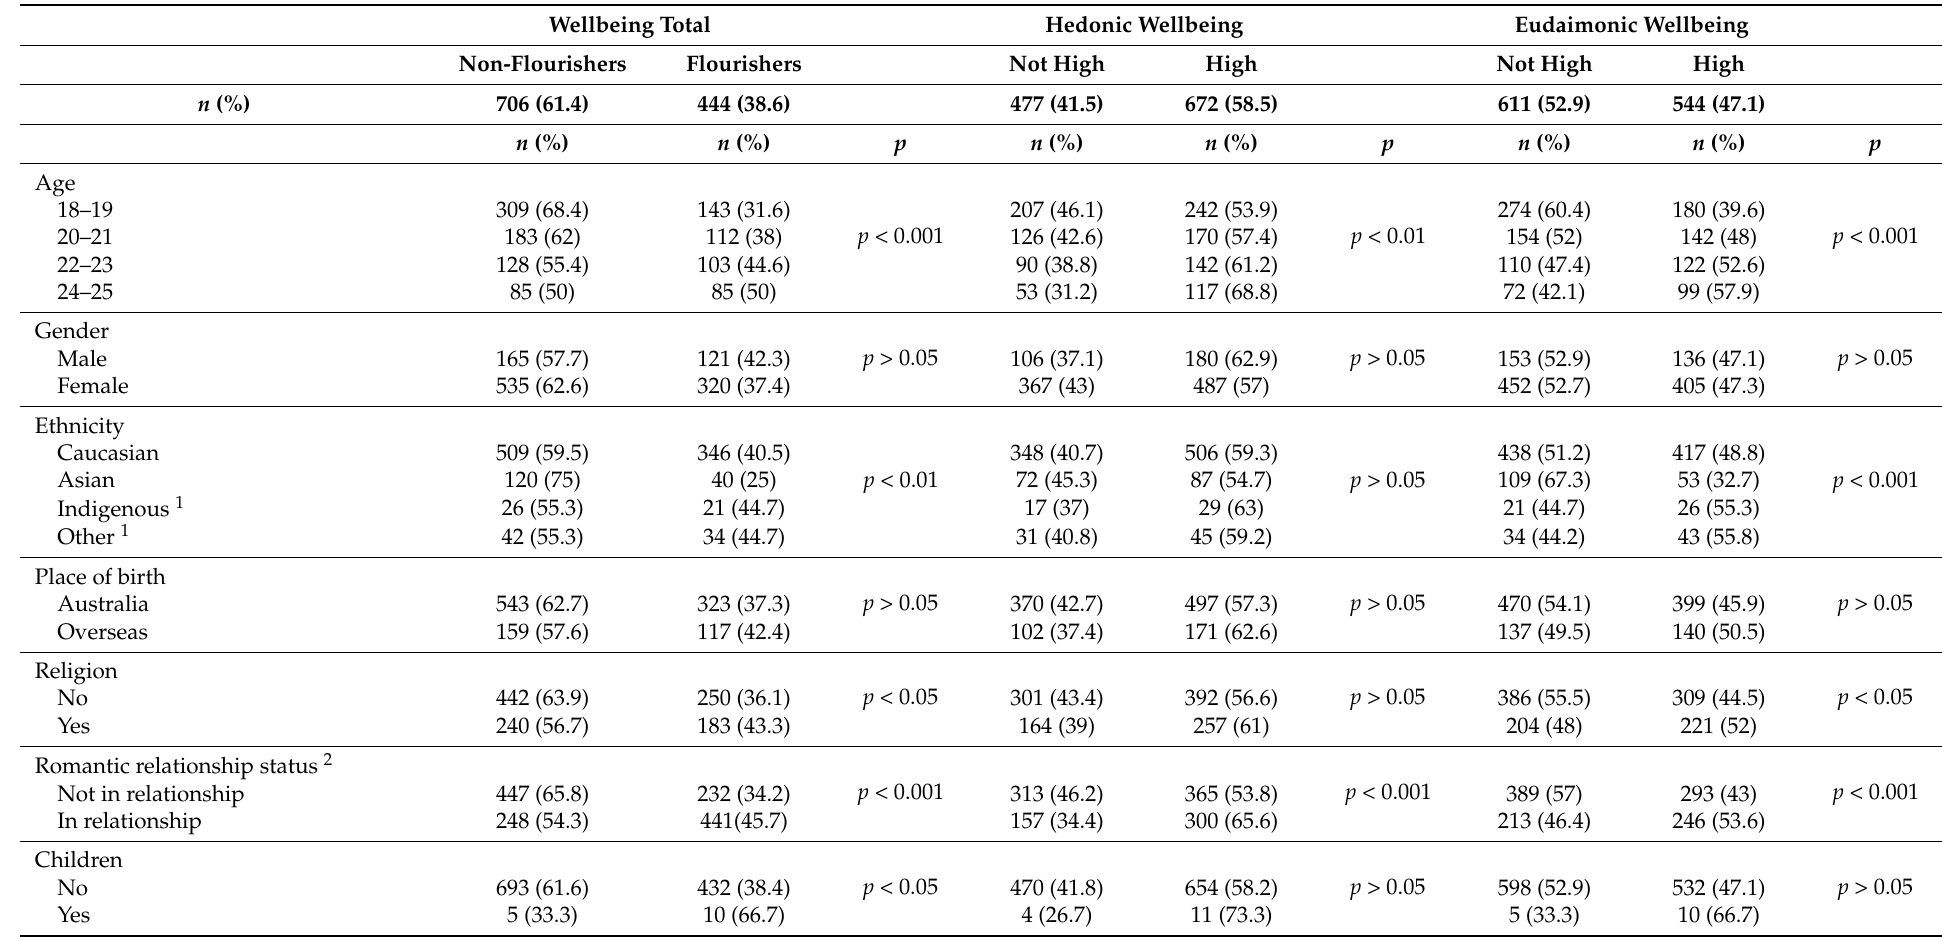
Table 2. Descriptive statistics and univariate analysis of wellbeing queried by socio-demographic factors and health status. Wellbeing